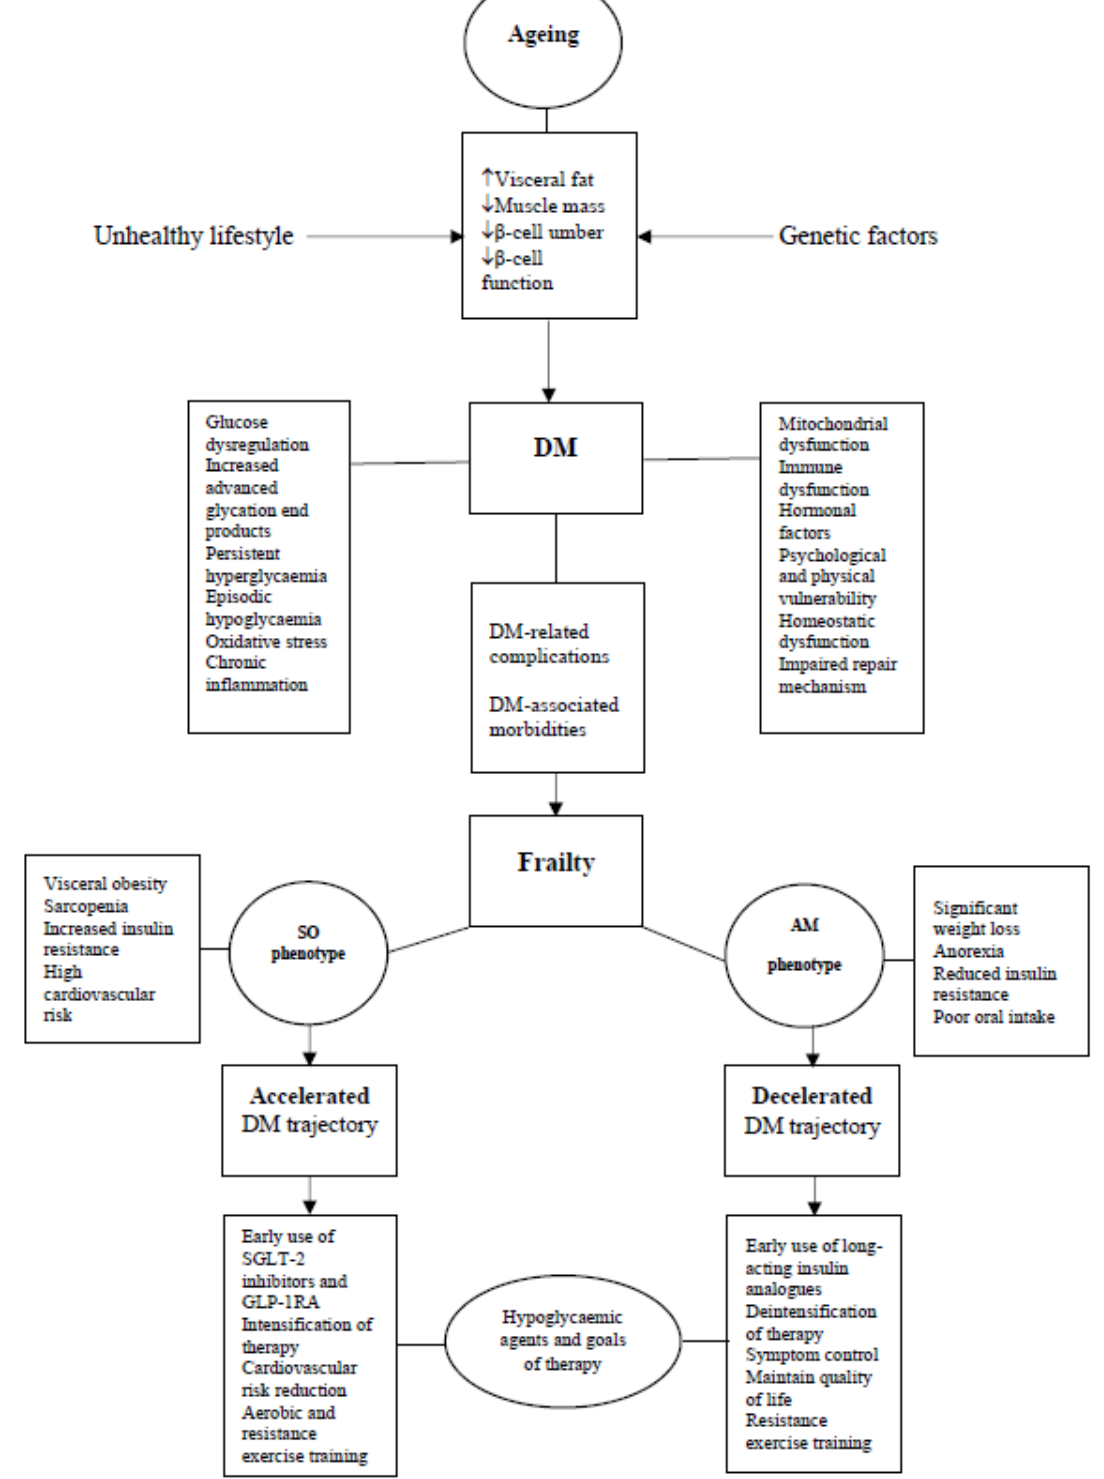
Figure 2. Ageing, diabetes and frailty. Age-related body composition changes predispose to glucose intolerance. In the presence of environmental and genetic factors, diabetes develops. Diabetes-related complications and associated comorbidities lead to emergence of frailty. Frailty metabolic phenotypes affect diabetes trajectory. Diabetes trajectory is accelerated in SO phenotype, which requires intensification of therapy, while it is decelerated in AM phenotype, which requires deintensification of therapy. DM = diabetes mellitus, SO = sarcopenic obese, AM = anorexic malnourished.